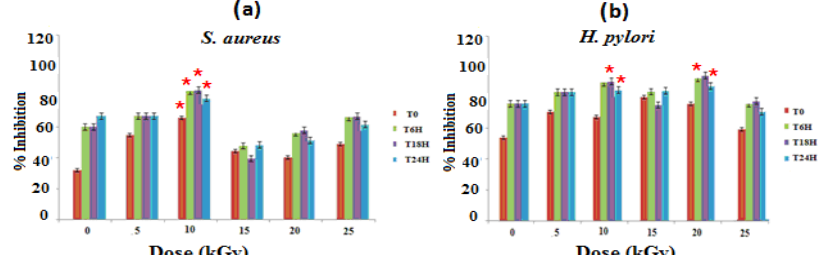
Figure 1. Determination of bacterial inhibitory effects of gelatine – chitosan – pomegranate peel (GEL – CH – PP) composite against S. aureus ( a ) and H. pylori ( b ) strain with different γ -radiation doses, 5, 10, 15, 20, and 25 kGy, in comparison with control samples (0 kGy). * Significant difference in the indicated group than that of the other groups at the same period of time ( p < 0.05).